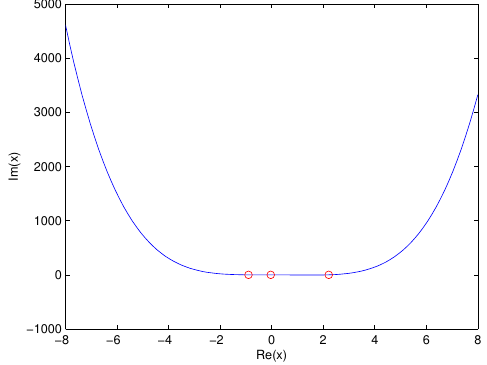
Figure 3. Shape and zeros of H B 4,1/2 ( x )